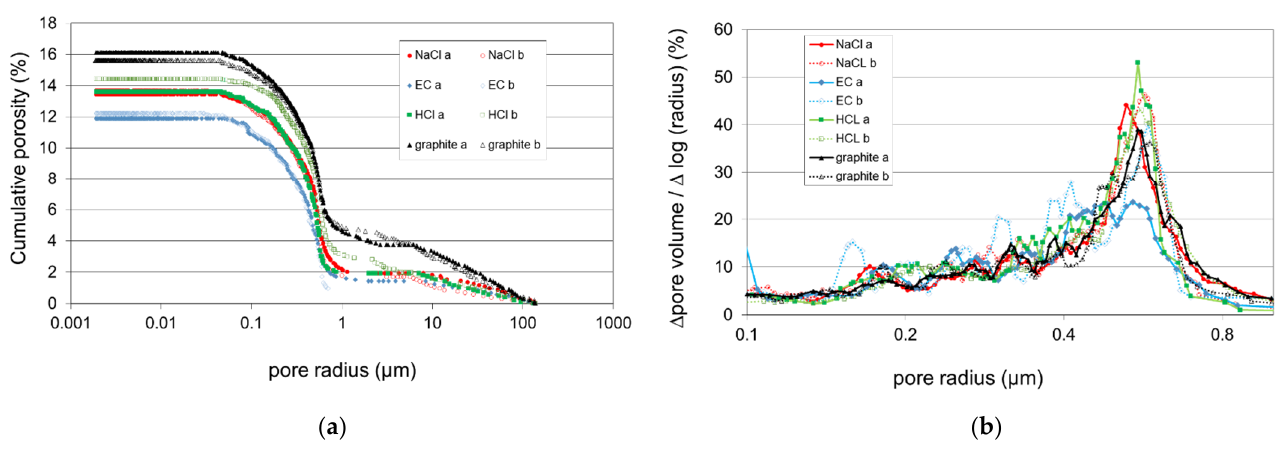
Figure 3. Mercury porosimetry results. ( a ) Cumulative pore volume of the whole measurement range and ( b ) differential pore volume of the size range between 100 nm and 1 µ m as a function of the pore radius (logarithmic